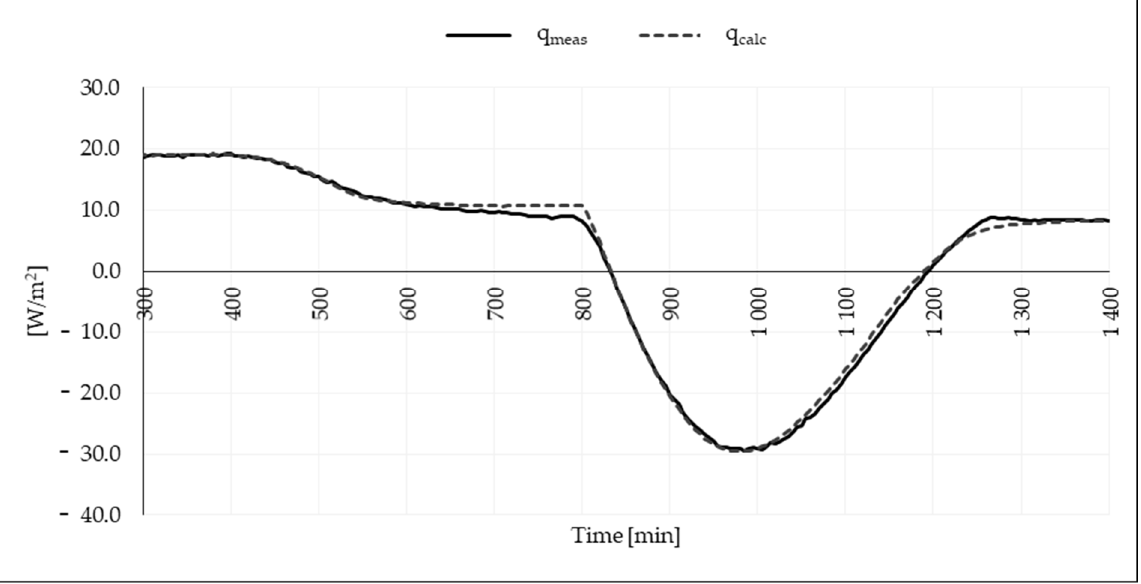
Figure 13. Comparison of the simulation ( q calc ) and experiment results ( q meas ).